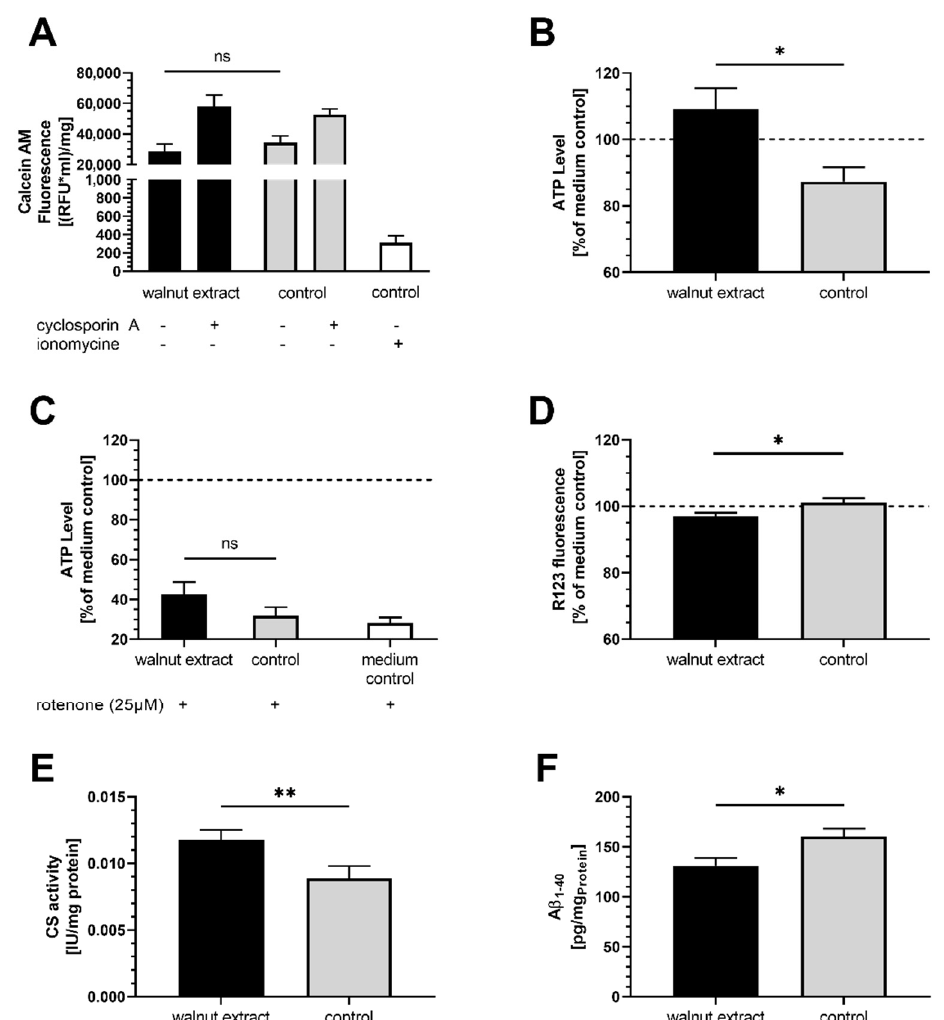
Figure 2. Effects of 10 µg/mL walnut lipid extract in SY5Y-APP695 cells. EtOH-12%BSA mixture served as control. ( A ) Mitochondrial membrane integrity reflected as the capacity to retain Calcein- AM (CAM) fluorescence dye. Displayed CAM fluorescence is adjusted to protein levels of the samples and reflects CAM captured in mitochondria only. Cytosolic CAM is quenched by CoCl 2 . Positive control ionomycin led to permeabilization of mitochondrial membrane and quenching of the majority of CAM. Cyclosporin A reduced the probability of opening of the mitochondrial permeability transition pore resulting in less CAM to be channeled from mitochondria to cytosol; n = 11. ( B ) Basal ATP concentrations; n = 8. ( C ) ATP concentrations following rotenone-induced (25 µM) complex I inhibition. White column represents medium control treated with rotenone; n = 10. ( D ) MMP determined as fluorescence of dye R123 taken up by the mitochondria; n = 7. ( E ) Citrate synthase activity adjusted to the protein content of the sample; n = 10. ( F ) Content of A β 1–40 in SY5Y-APP695 cells were determined via the HTRF method and adjusted to protein levels of the samples; n = 9. Displayed are means ± SEM. Significant differences (student’s t -test) are displayed as: ns p > 0.05, * p < 0.05, ** p < 0.01.